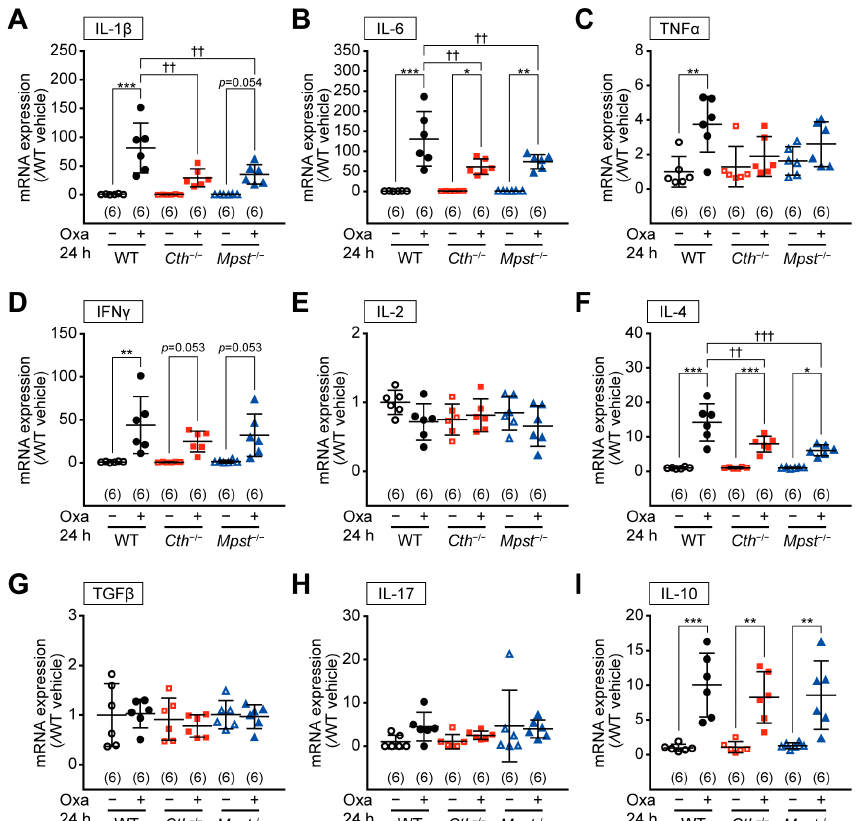
Figure 7. Expression levels of various cytokine mRNAs in the ear during oxazolone (Oxa) ‐ induced contact dermatitis at 24 h after the challenge. IL ‐ 1 β ( A ), IL ‐ 6 ( B ), TNF α ( C ), IFN γ ( D ), IL ‐ 2 ( E ), IL ‐ 4 ( F ), TGF β ( G ), IL ‐ 17 ( H ), and IL ‐ 10 ( I ) mRNA levels were normalized by the housekeeping HPRT1 mRNA levels, and the relative expression versus vehicle ‐ treated wild ‐ type samples were calculated. Data are the mean ± SD with sample numbers in parentheses. Differences are significant by a one ‐ way ANOVA with Tukey’s multiple comparison test at * p < 0.05, ** p < 0.01, and *** p < 0.001 versus vehicle ‐ treated samples of each genotypes; †† p < 0.01 and ††† p < 0.001 between genotypes.